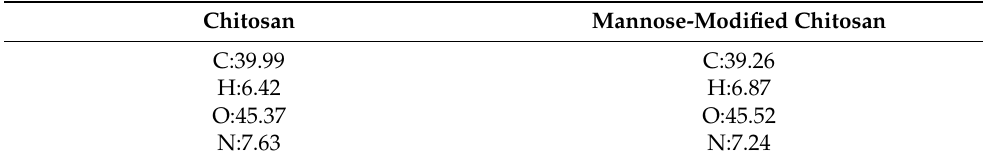
Table 2. The results of elemental analysis.